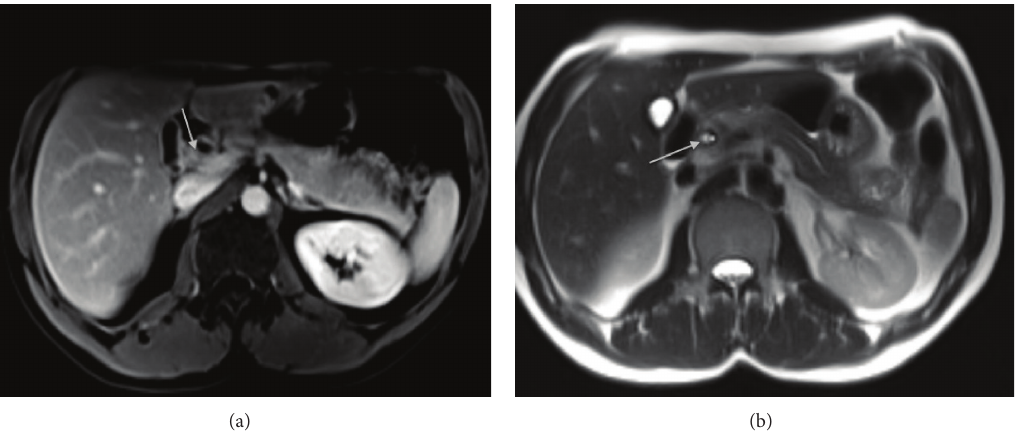
Figure 1: (a) T1 weighted axial postcontrast MRI, asymmetric contrast-enhancing lesion in distal choledoch, and indentation to portal vein